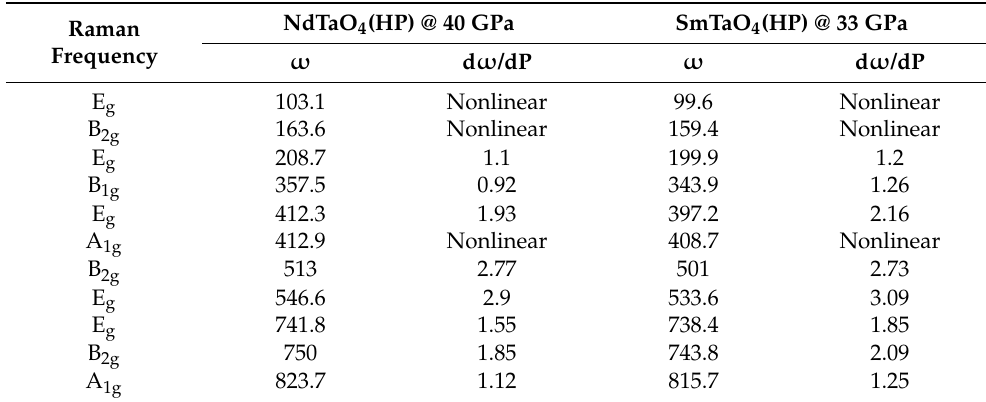
Table 5. Calculated Raman modes for NdTaO 4 and SmTaO 4 at transition pressure along with their pressure coefficients (present work).